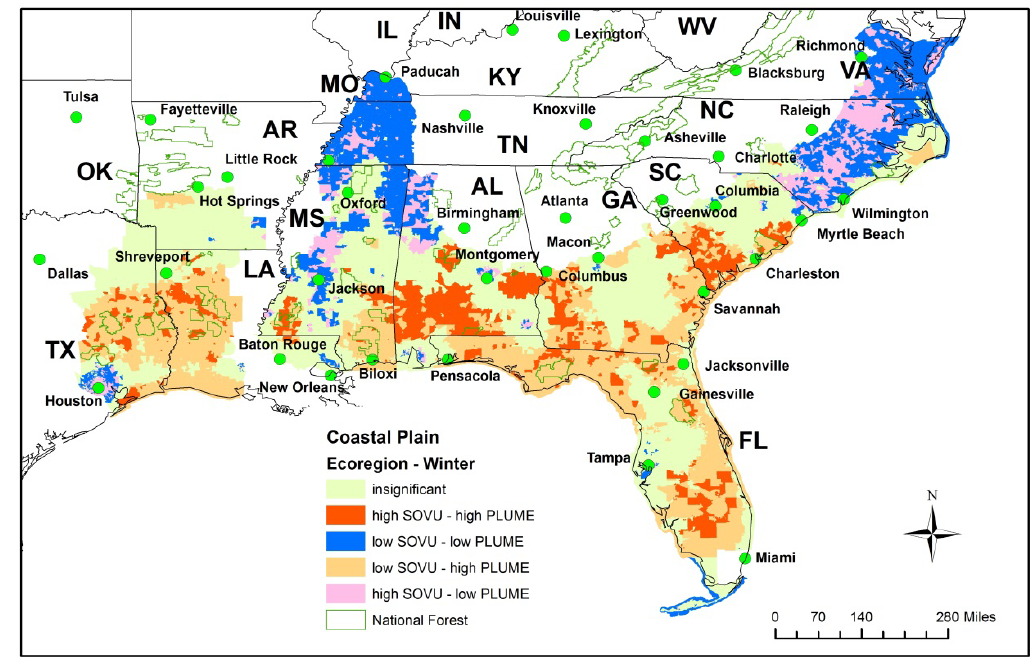
Figure 8. Bivariate LISA mapping of social vulnerability and smoke plume in the Coastal Plain ecoregion—winter.